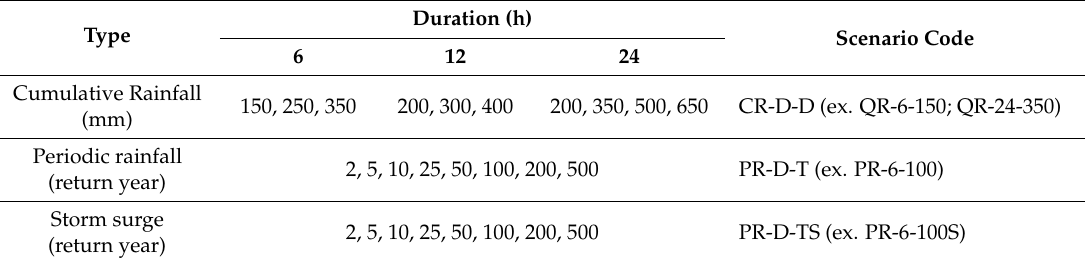
Table 6. Forty-two scenarios are assumed for producing